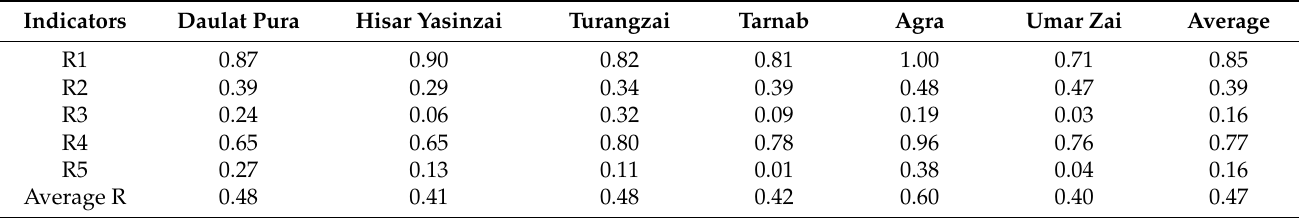
R1, flood risk awareness; R2, employment; R3, secondary income sources; R4, social network; and R5, financial capacity for